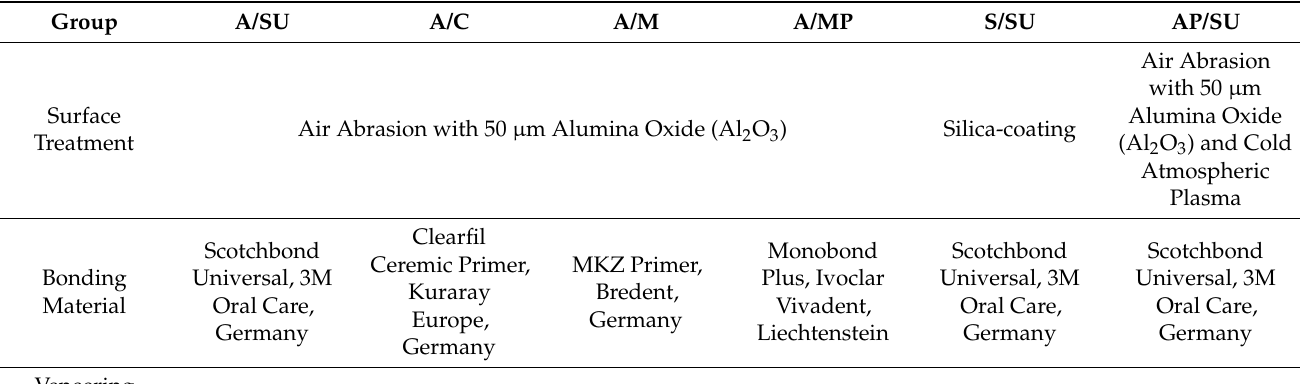
Table 1. Composition of test groups and the materials used. Surface treatments, bonding materials, and veneering composites are displayed to the corresponding groups. A/SU: air abrasion and Scotchbond Universal; A/C: air abrasion and Clearfil Ceramic Primer; A/M: air abrasion and MKZ Primer; A/MP: abrasion and Monobond Plus; S/SU: silica-coating and Scotchbond Universal; AP/SU: air abrasion, additional cold atmospheric plasma treatment (CAP) and Scotchbond